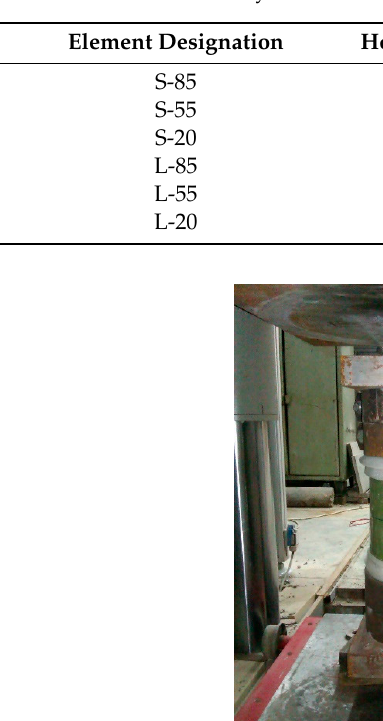
Table 1. Summary of the tested elements and their selected features.